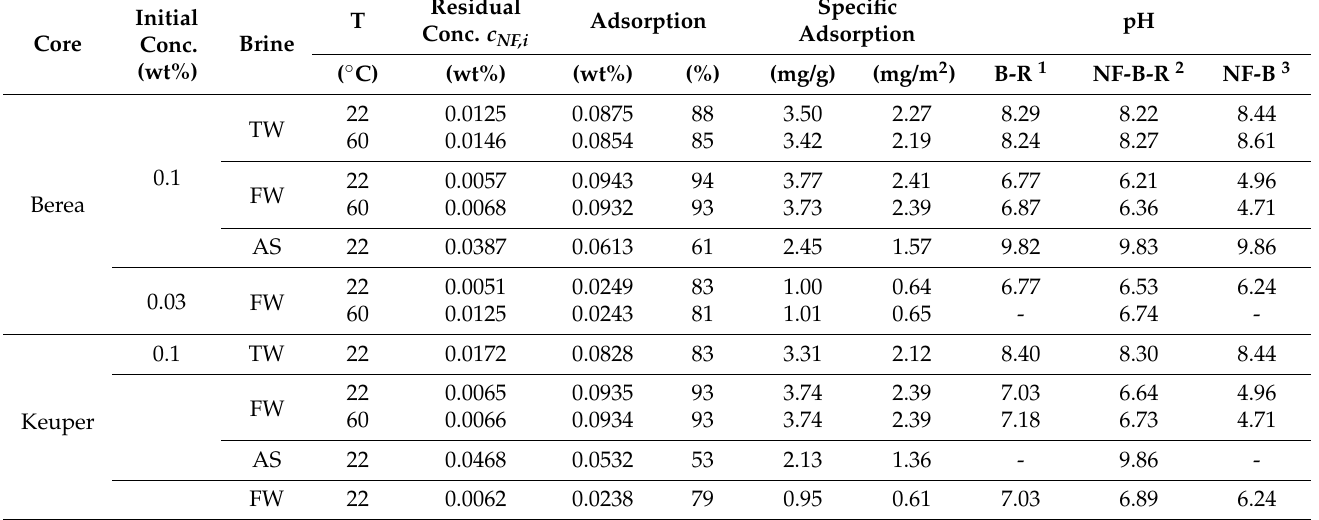
Table 6. Adsorption results and pH measurements for NF B in Berea and Keuper. Absorbance measurements were performed in doublets with an average standard deviation of 7.4 × 10 − 4 for all fluids. pH standard deviation was defined as 2 × 10 − 2 for all fluids in average. Note the increase in pH from 4.71 to 6.36 for 0.1 wt% NF B in FW at 60 ◦ C. Note the increase in pH from 4.71 to 6.36